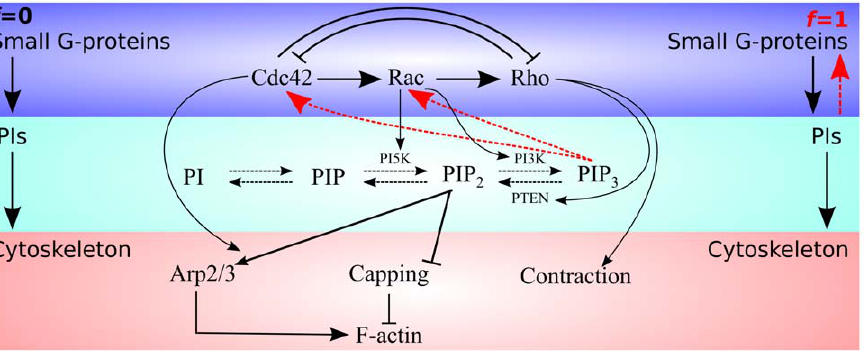
Figure 1. Signalling pathways assumed in the model. The top row represents small GTPases, the middle row depicts phosphoinositides, and at the lowest level are the cytoskeletal components. Here we explore the effects of feedback from the PIs to the small GTPases, indicated by the red dashed lines. The parameter f in the model represents the magnitude of the feedback ( f ~ 0 means the feedback is absent, f ~ 1 means it is essential for activating Cdc42 and Rac).